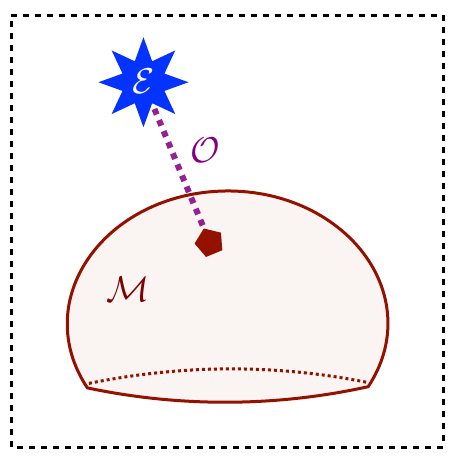
as the distance of closest approach, as measured by O and a manifold of events. Many classic collider observables (cid:12)t E M